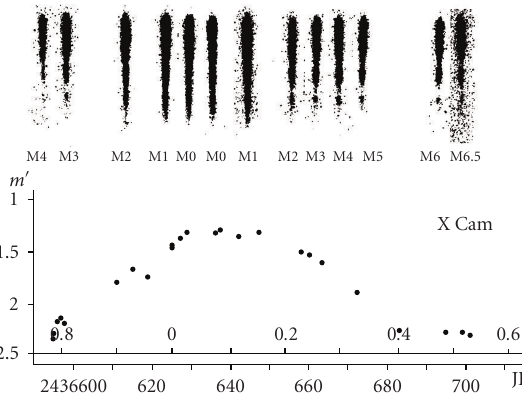
Figure 5: Spectral and photometric variability of X Cam [12].